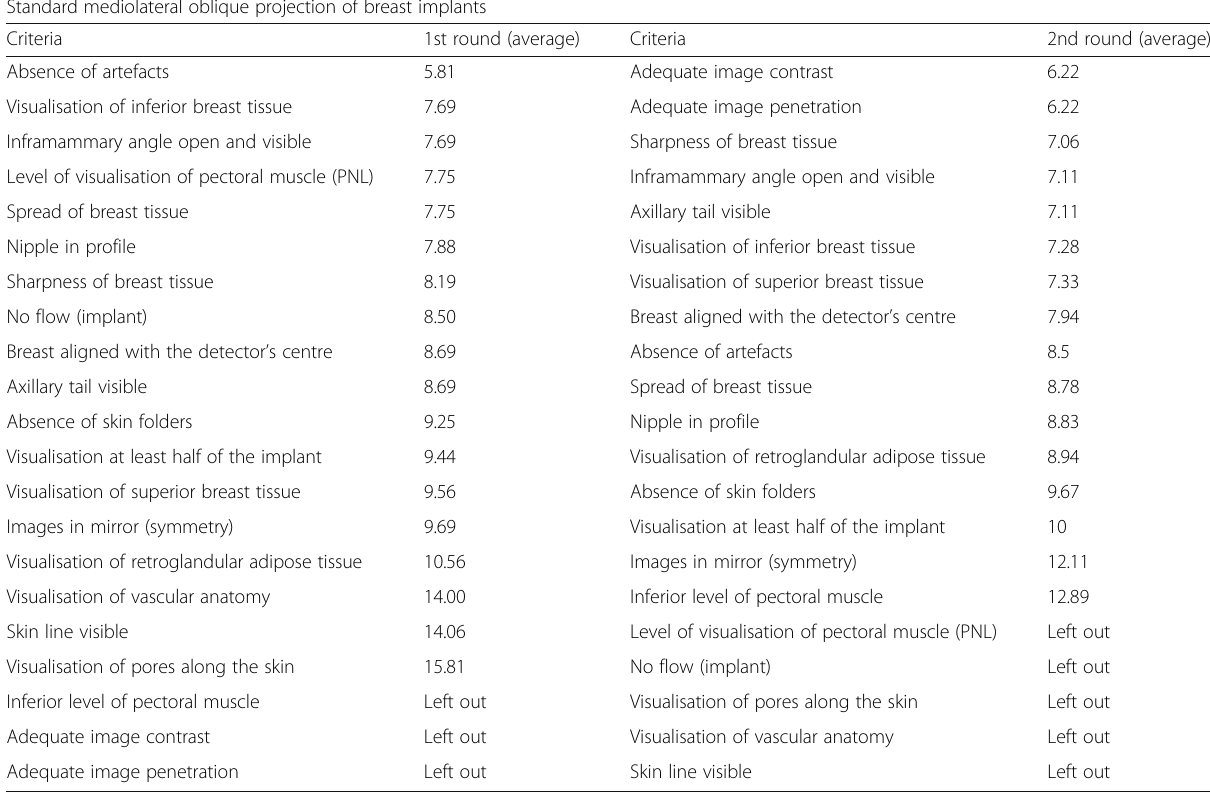
Table 5 Criteria rakings (mean values based on Kendall ’ s W ) comparison between first and second Delphi rounds regarding mediolateral oblique image manoeuvre combining the opinions of both groups (radiologists and radiographers) Standard mediolateral oblique projection of breast implants